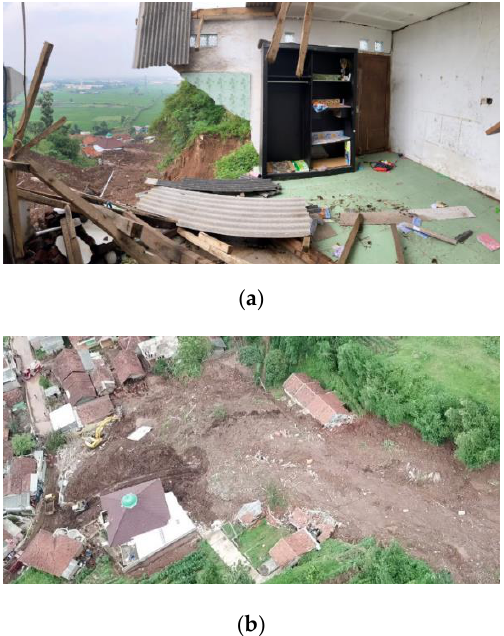
Figure 2. Destruction caused by the slope failure (( a ) shows destruction of house located at the edge of the slope; ( b ) shows buried house at the bottom of the slope).